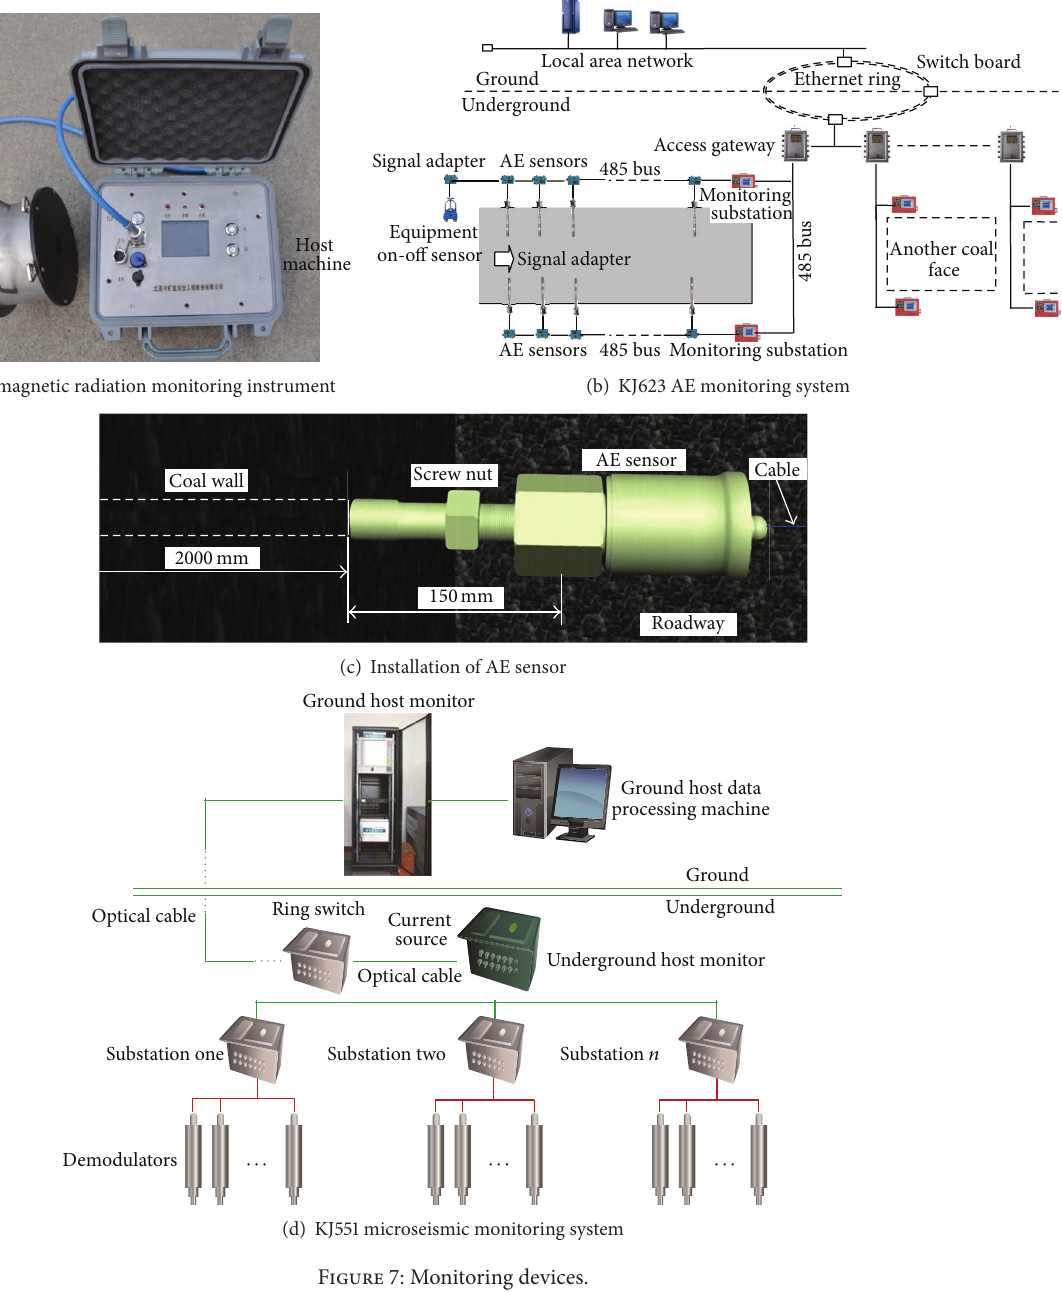
Figure 7: Monitoring